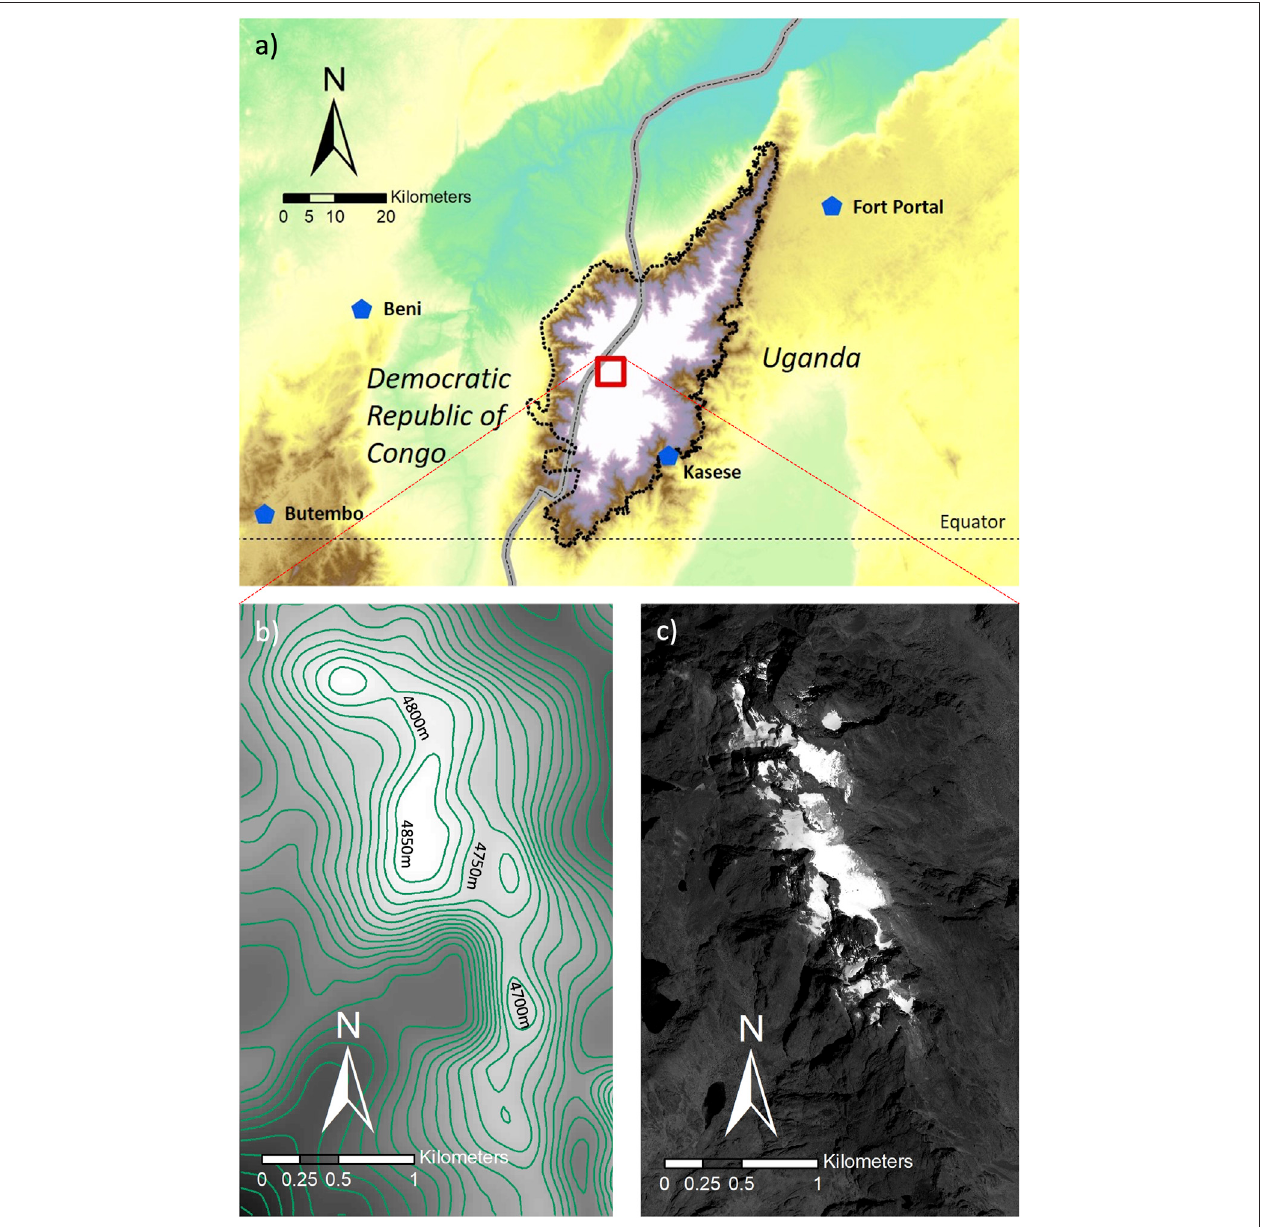
FIGURE 1 | (A) Map of the Rwenzori region (bold dotted contours) with national borders between Uganda and D.R. Congo (thick grey line); (B) DEM (SRTM) of Stanley Plateau area, with 50 m contour lines; (C) satellite image (Worldview) of Stanley Plateau area, with the same extent and scale as in (B) .